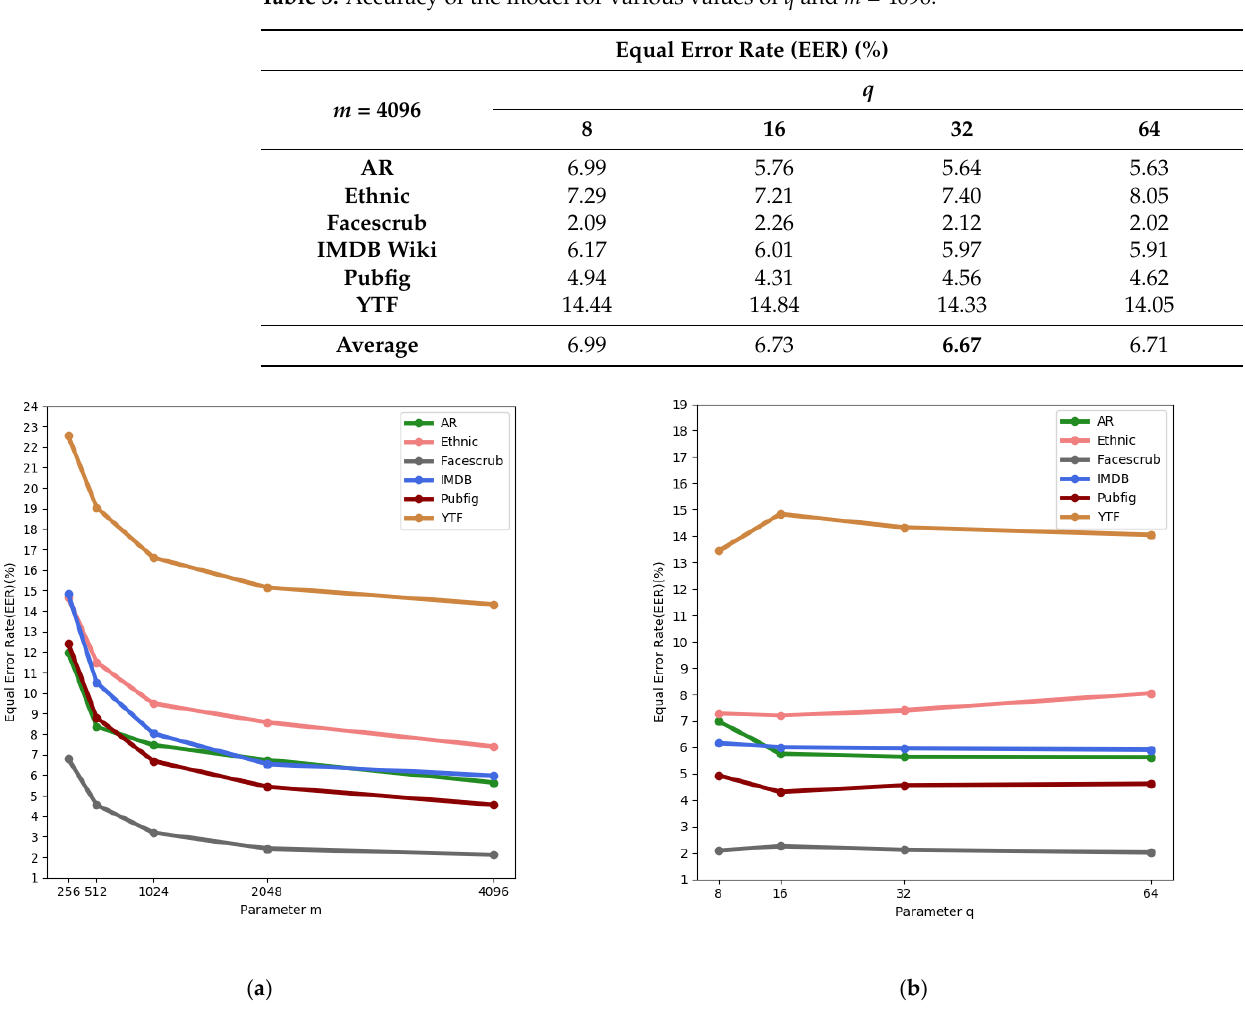
Table 3. Accuracy of the model for various values of q and m = 4096.